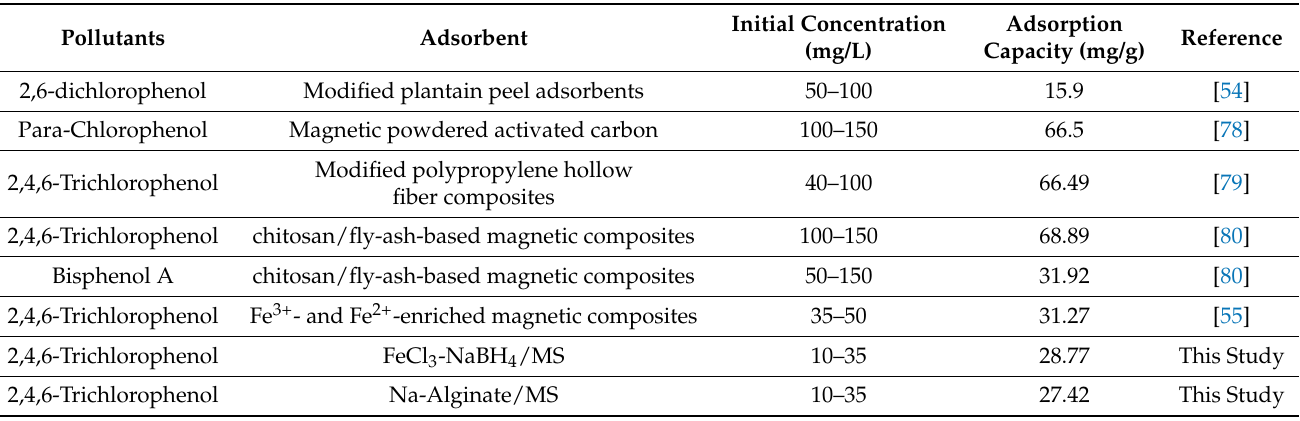
Table 7. Comparison of adsorption capacities reported in current work and adsorption capacities of other adsorbents reported by various